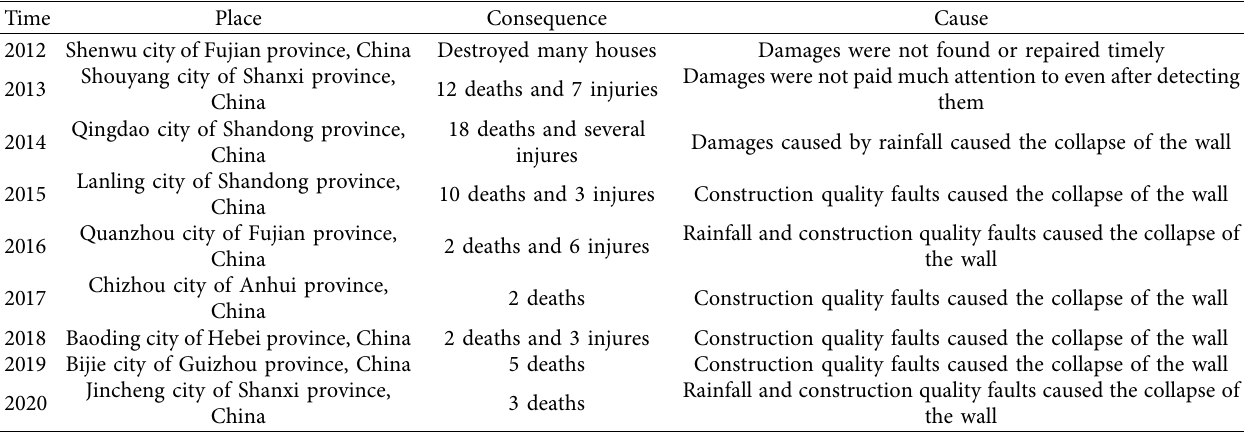
Table 1: Accidents due to retaining walls